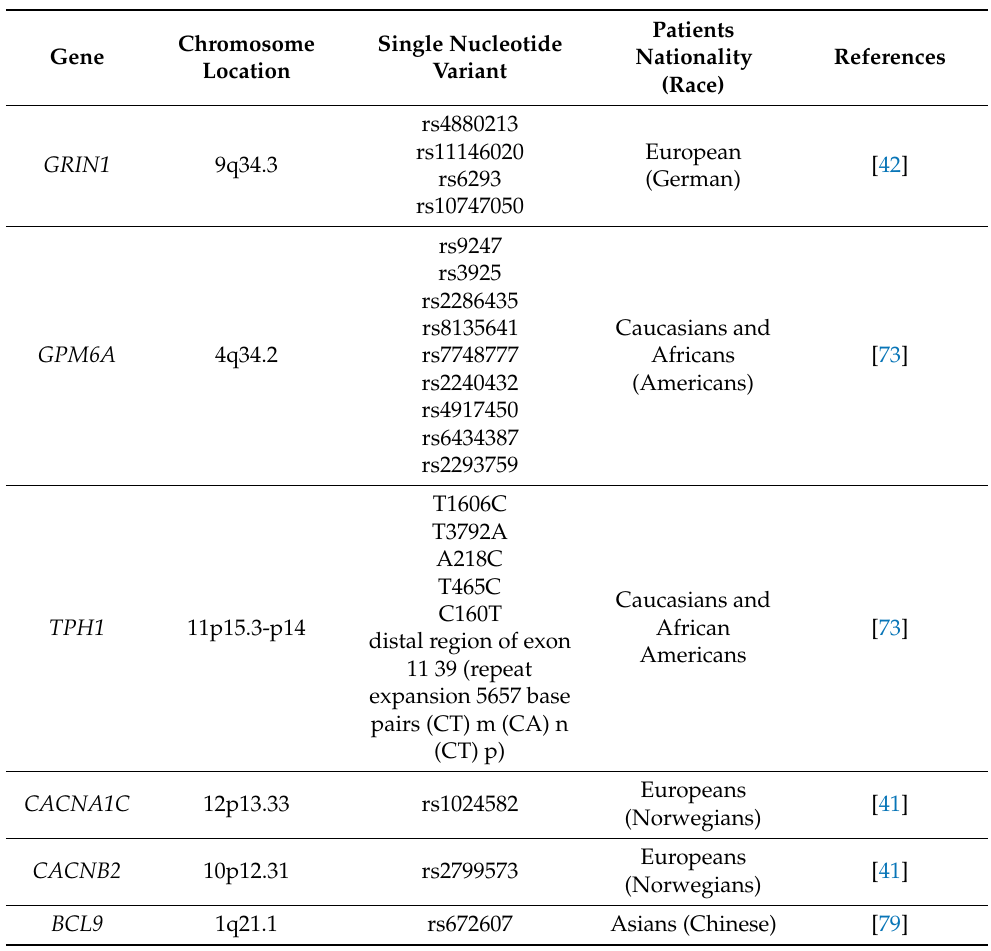
Table 4. Candidate genes and their single nucleotide variants associated with comorbidity of schizophrenia and